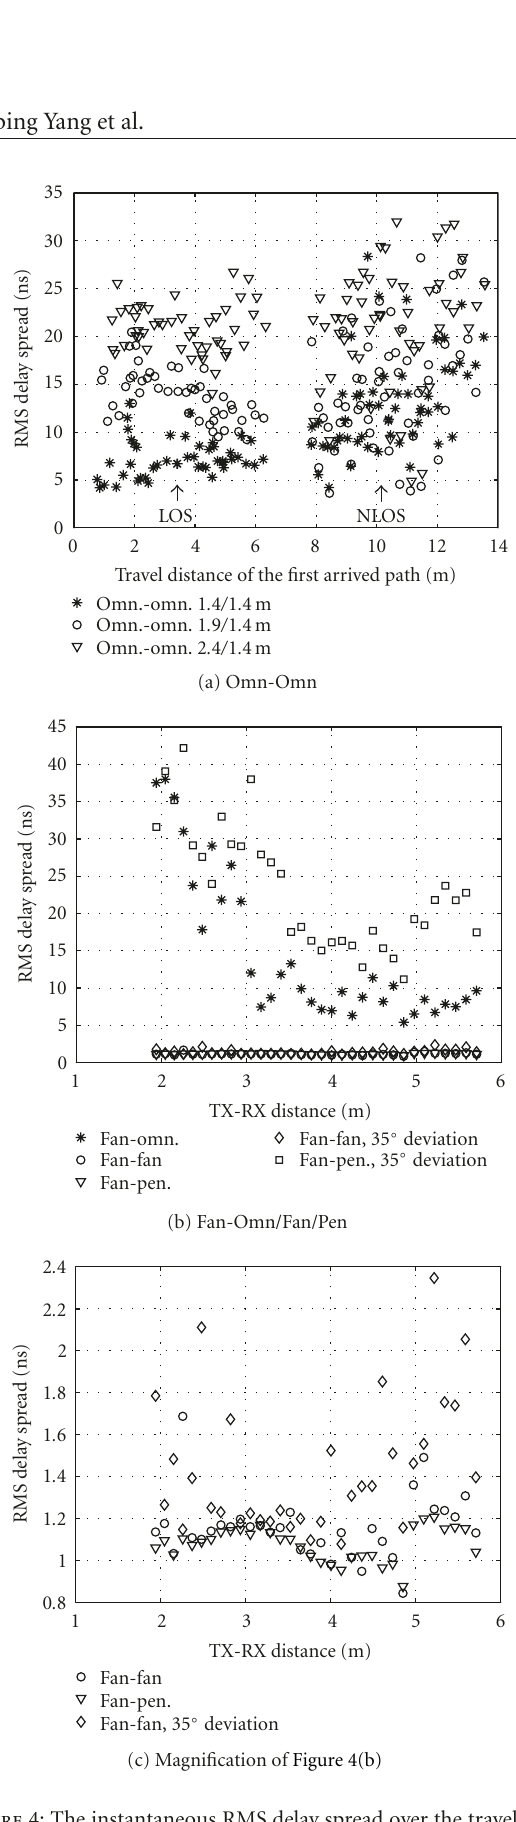
Figure 4: The instantaneous RMS delay spread over the travel dis- tance of the first arrived